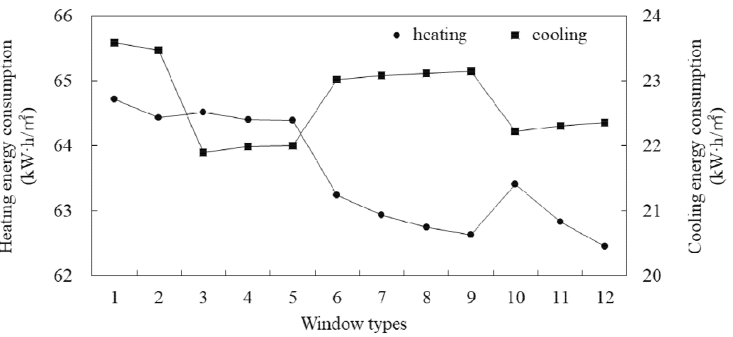
Figure 11. Relationships between window thermal performance and heating and cooling en- ergy